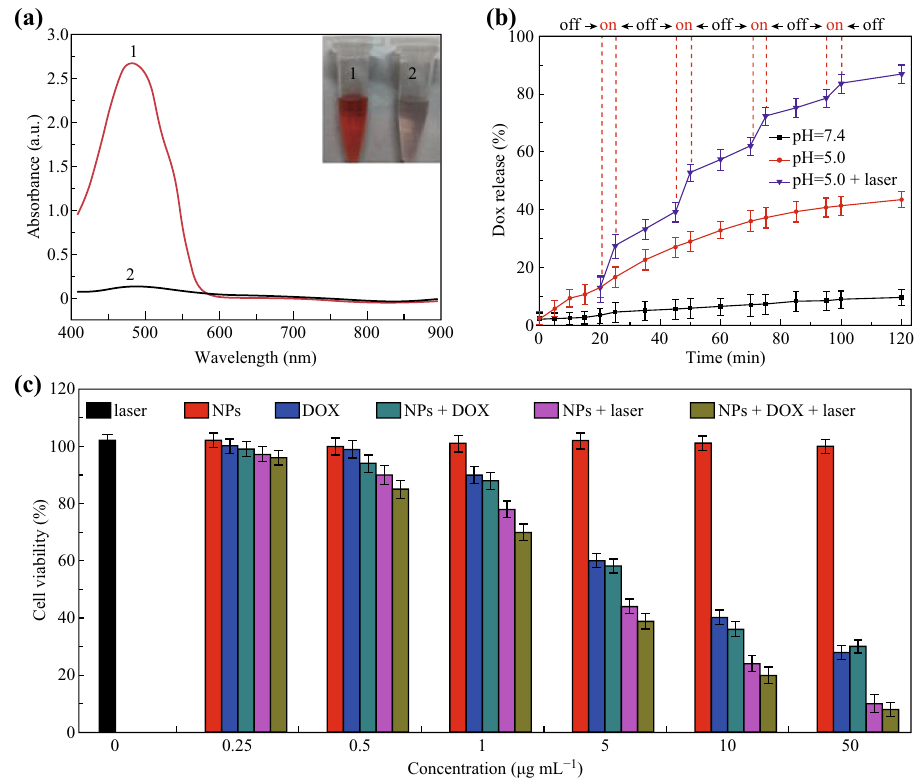
Fig. 3 a UV–Vis absorption spectra and photographs (inset) of original DOX aqueous solution (1) and the residual DOX content in the supernatant after interaction with AuNR@PAA/CaP yolk–shell NPs (2); b DOX-release profiles of DOX from DOX-loaded yolk–shell NPs in PBS buffer: pH = 7.4, 5.0 and 5.0, with periodic laser ON/OFF irradiation (808 nm, 1.0 W cm - 2 ), c Cytotoxicity assays of HeLa cells incubated with different treatments (laser, NPs, DOX, NPs ? DOX, NPs ? laser and NPs ? DOX ? laser, laser irradiation: 1.0 W cm - 2 , 5